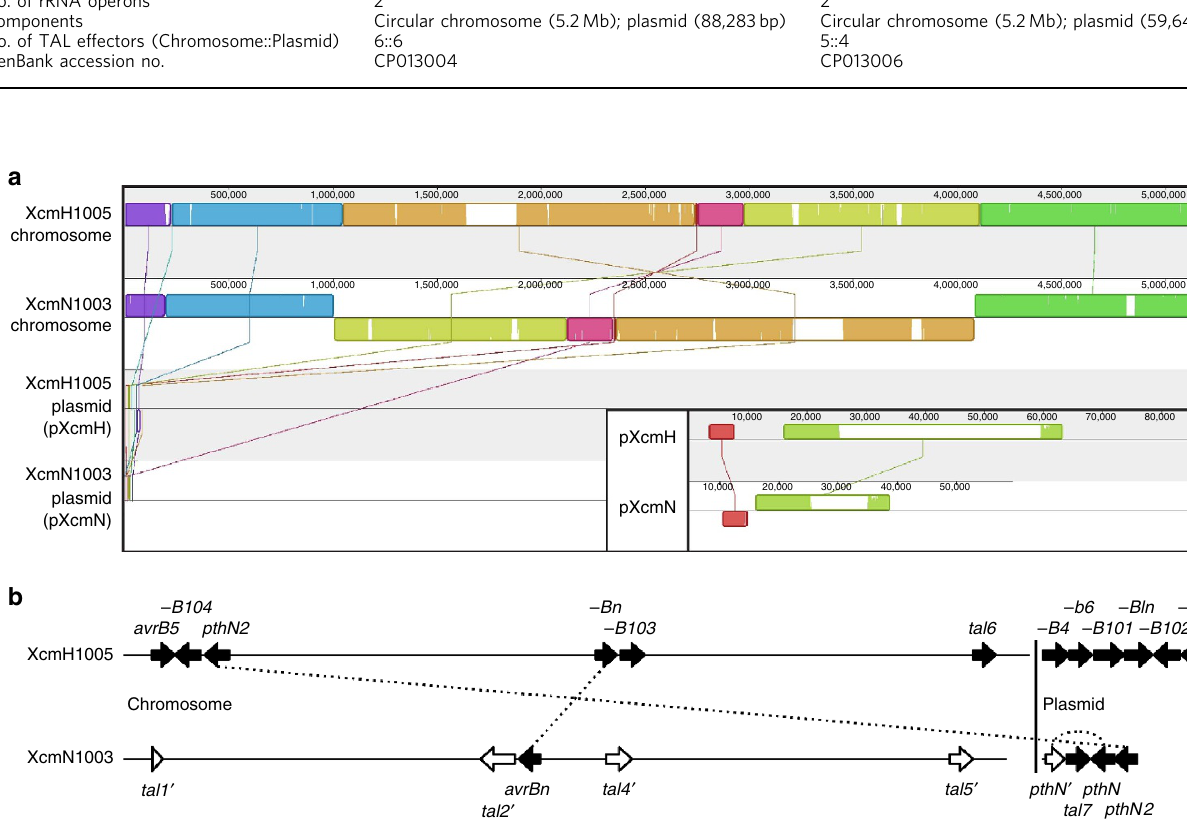
Figure 1 | Comparison of whole genomes and tal genes of Xcm H1005 and Xcm N1003. ( a ) Alignment of the Xcm H1005 and Xcm N1003 genomes, generated using progressiveMAUVE with default parameters 68 . Each genome comprises a single circular chromosome and a single circular plasmid, shown linearized. Coloured, rounded rectangles represent locally collinear blocks (LCB), regions of homology without rearrangement across the aligned sequences, connected by matching coloured diagonal lines. The orientations of the LCB, forward or reverse, are indicated by their position above or below the line, respectively. The height of a column within a block reflects the average similarity relative to the other aligned sequence(s) there (see http://darlinglab.org/ mauve/user-guide/viewer.html for details). Inset (bottom right) shows the alignment of the plasmids only, at a larger scale. Horizontal axes show sequence coordinates (bp). MAUVE backbone files giving the exact coordinates of all LCB are provided as Supplementary Data 1 (all molecules aligned) and Supplementary Table 1 (plasmids only). ( b ) The tal genes of Xcm H1005 and Xcm N1003. The genes are represented as block arrows at their relative positions in the chromosome or plasmid (horizontal lines). The arrows are magnified relative to the rest of the genome, but intergenic regions and arrow sizes relative to each other are to scale. Dashed lines connecting two arrows indicate identical encoded RVD sequences. Gene names follow the scheme of ref. 41, except for the indicated avr and pth genes, named previously 10,38–40 . For label clarity, hypens replace ‘ avr ’. An apostrophe following the gene name (white arrows) indicates that the coding sequence is terminated early due to a frameshift mutation or other coding sequence disruption. Details, including RVD sequences and AnnoTALE designations 53 , are given in Supplementary Table